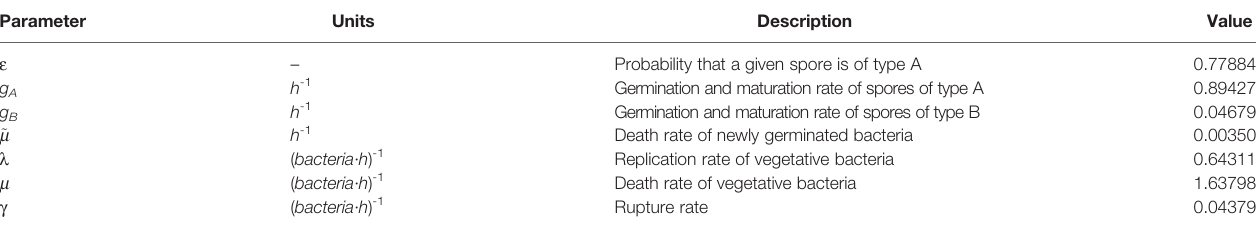
TABLE 5 | Parameter values that gave the smallest distance between the two types of spores model and the data from (23) in the ABC-SMC